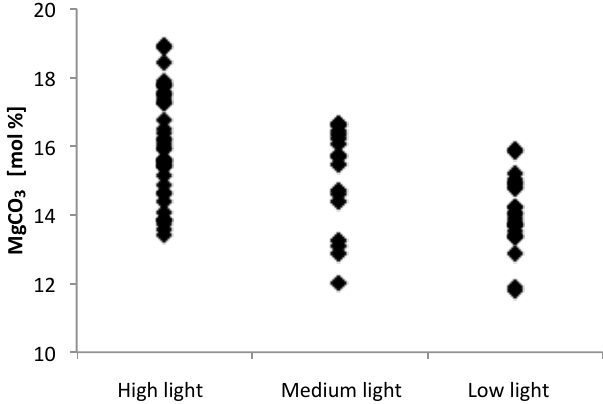
Figure 13. MgCO 3 concentrations at each experimental light level (all temperatures combined).